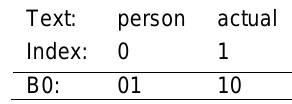
Table 9: Word-frequency table for length five